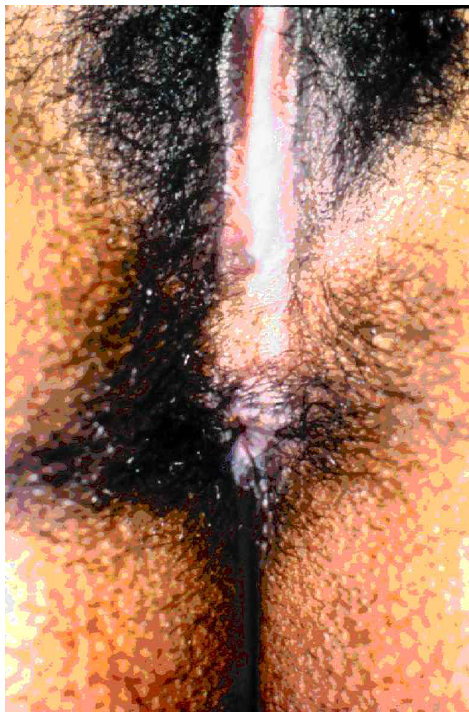
Figure 7 Case 2; patient completely